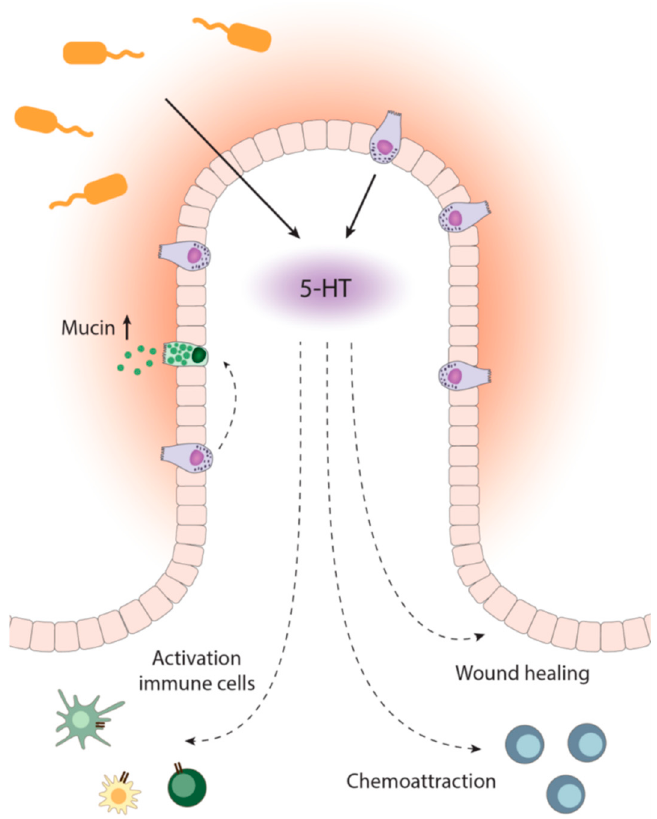
Figure 2. Overview of 5-HT action in the intestine. 5-HT is produced by microbes and EC cells. Subsequently, immune cells are activated, and processes such as chemoattraction and wound healing are activated—furthermore, mucus production by epithelial goblet cells increases. 5-HT: 5-hydroxytryptamine; EC: enterochromaffin.